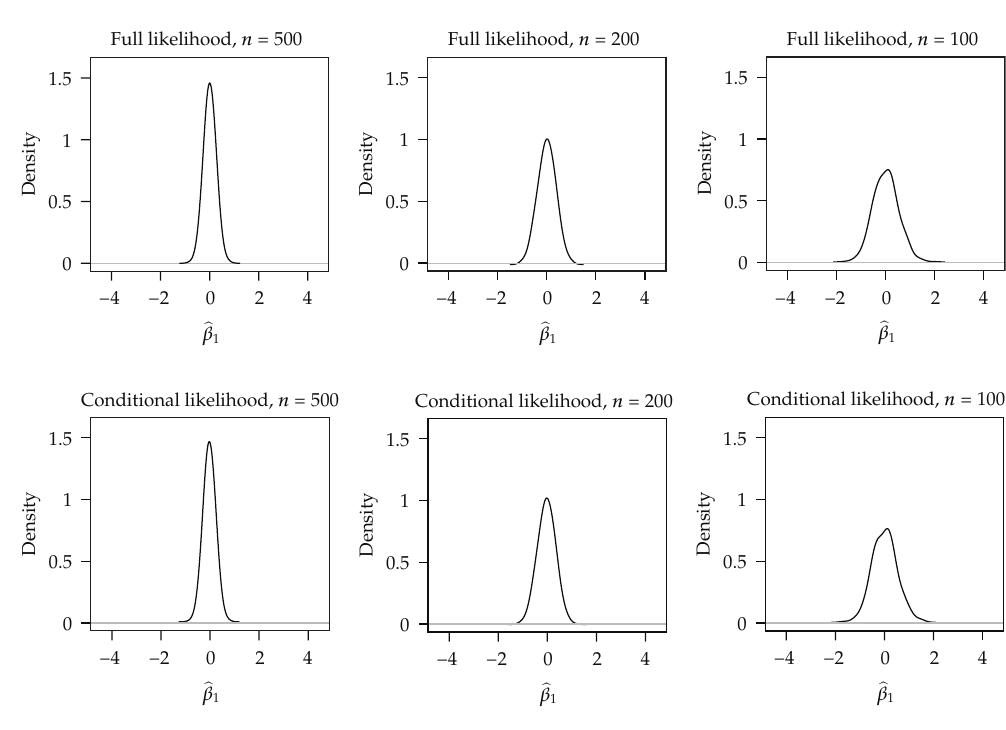
Figure 1: Sampling distributions for maximum likelihood estimates of regression coe ffi cient β 1 from 1000 replications; normal model fitted to normal data (cid:5) Y i ∼ N (cid:5) 4 , 4 (cid:6)(cid:6)